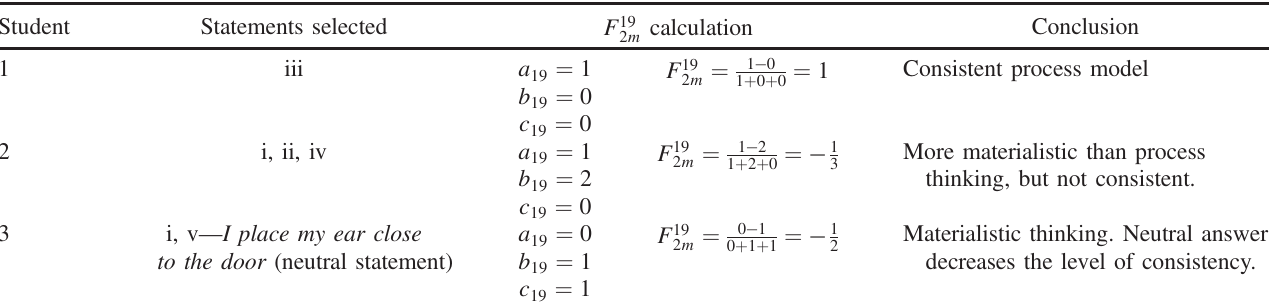
TABLE I. Three hypothetical examples of responses in item 19, the appropriate F 2 m values ’ calculation, and what kind of mental model state they